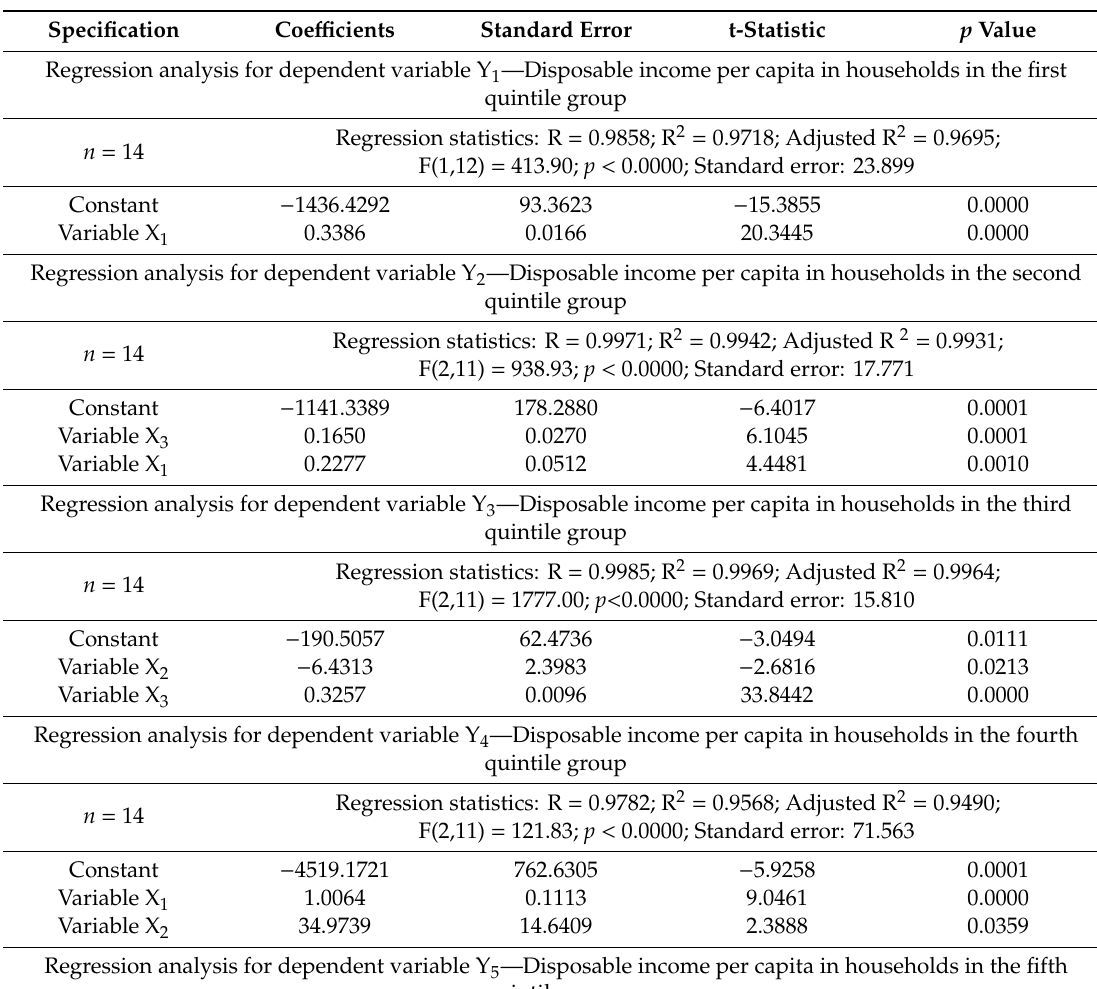
Table 2. Results of regression analysis for households’ disposable income by quantile